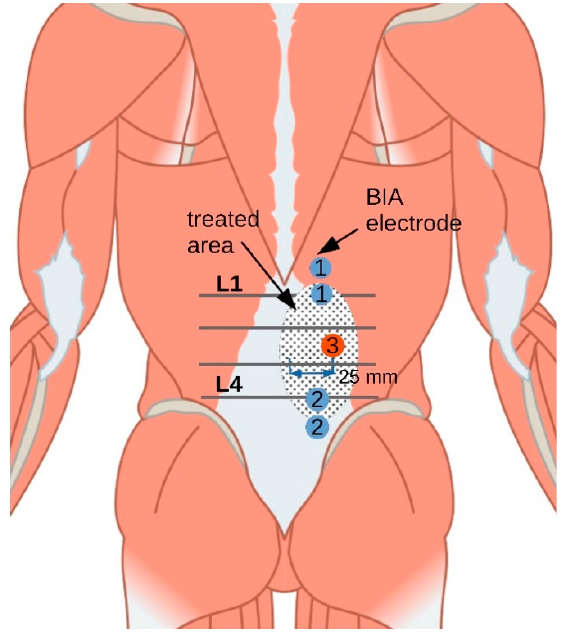
Figure 2. Measuring arrangement. 1, electrode pair 1; 2, electrode pair 2; 3, measurement point MP 1 ; BIA, bioimpedance analysis; L1, 1st lumbar vertebra; L4, 4th lumbar vertebra.